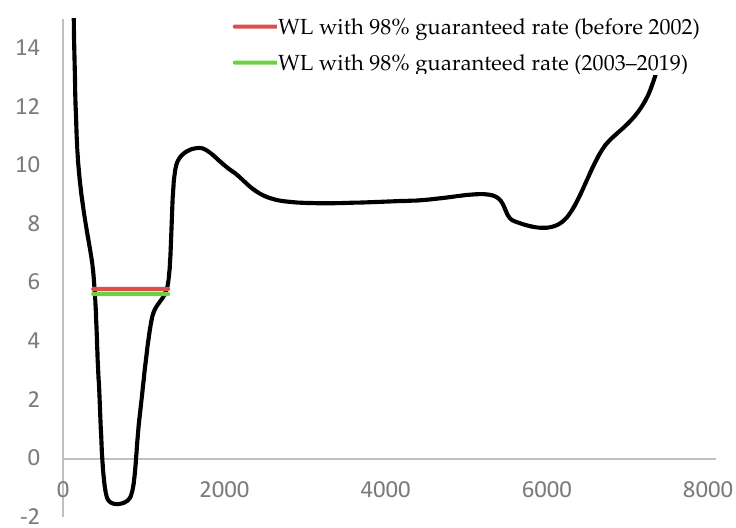
Figure 10. Navigable depth analysis of the Hukou section.